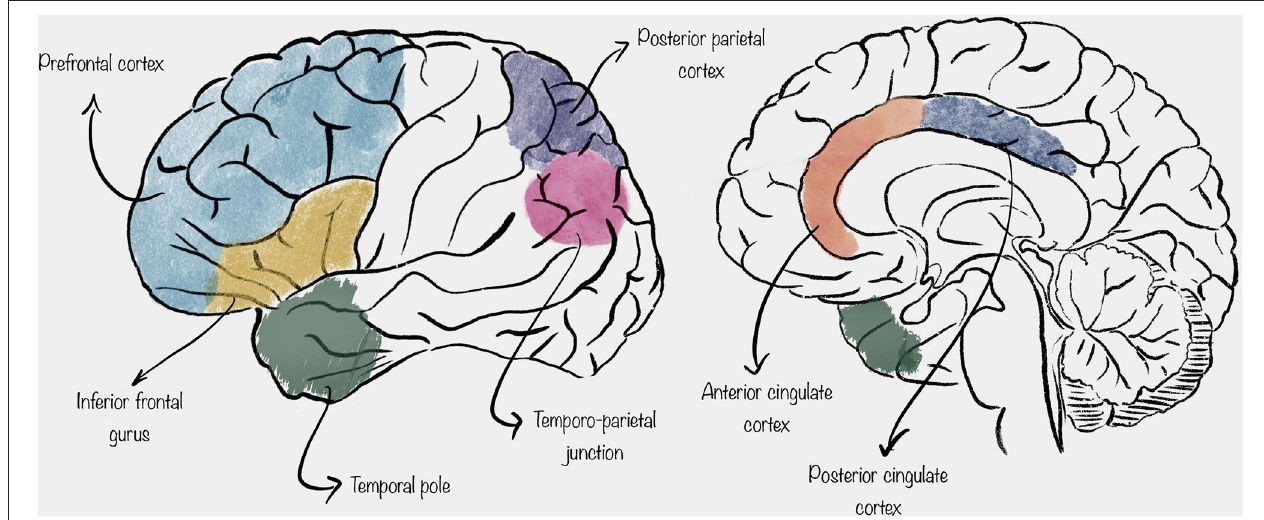
FIGURE 1 | Schematic representation of the location of the cortical areas described in this